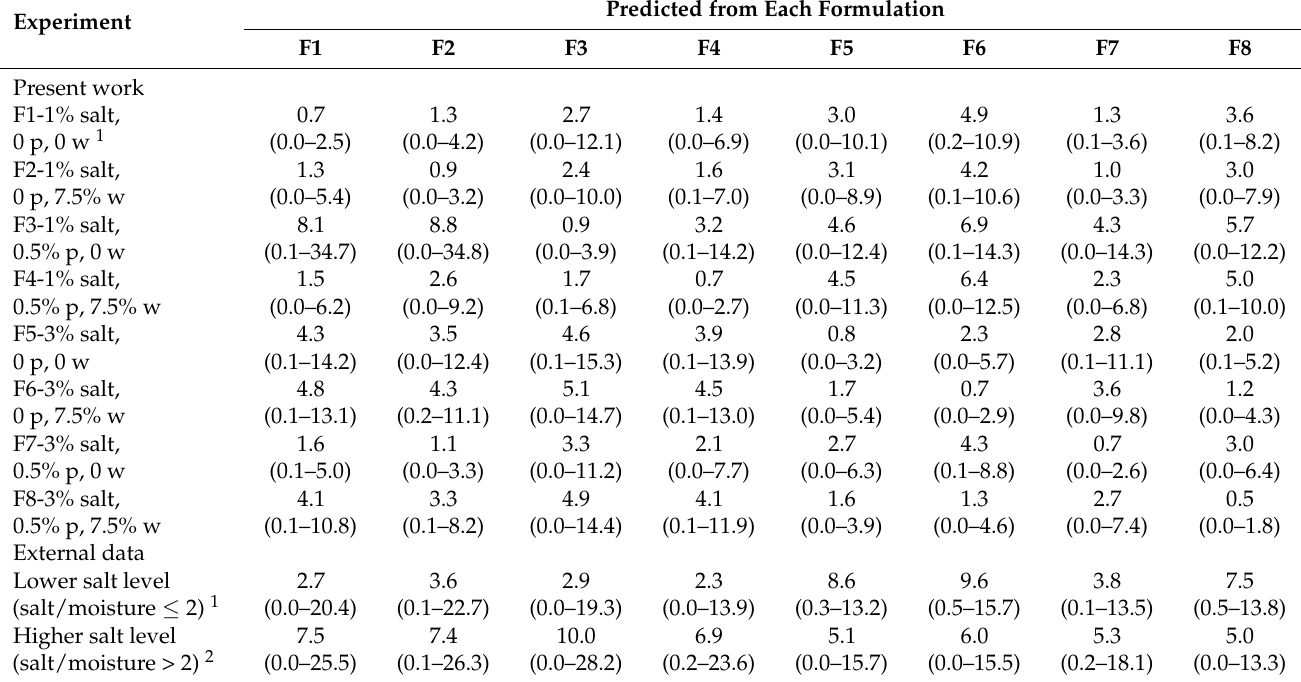
Table 4. Percentage of deviation obtained in the prediction of aw using the eight equations obtained from each formulation. Data used as predictors are from the present work and external data. The results are presented as the mean (minimum-maximum) of the percentage of